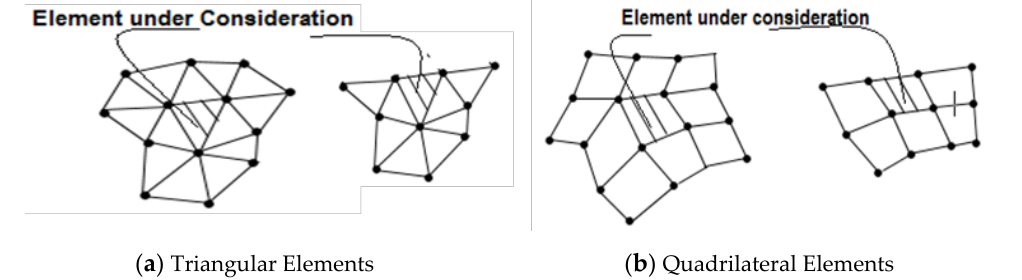
Figure 3. Element patches for least square (Displacement) and RPI (Displacement) recovery technique (mesh dependent).